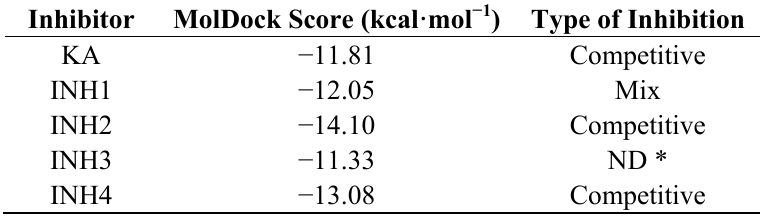
Table 3. Docking energy results obtained using MVD program and MolDock score